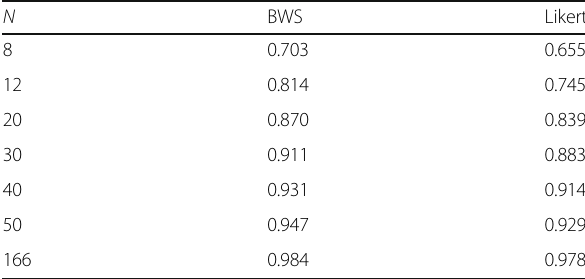
Table 2 Mean Cronbach ’ s alpha calculated from 50 random samples of size N from each of the BWS and Likert